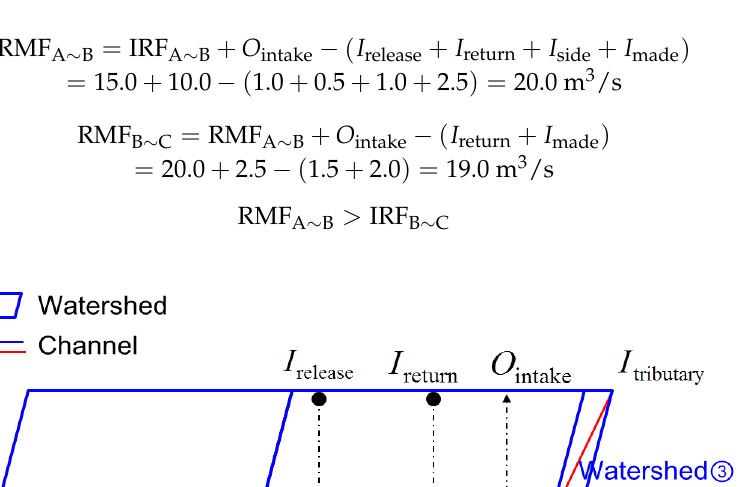
Figure 7. Schematic showing calculation of the RMF for the main stream.